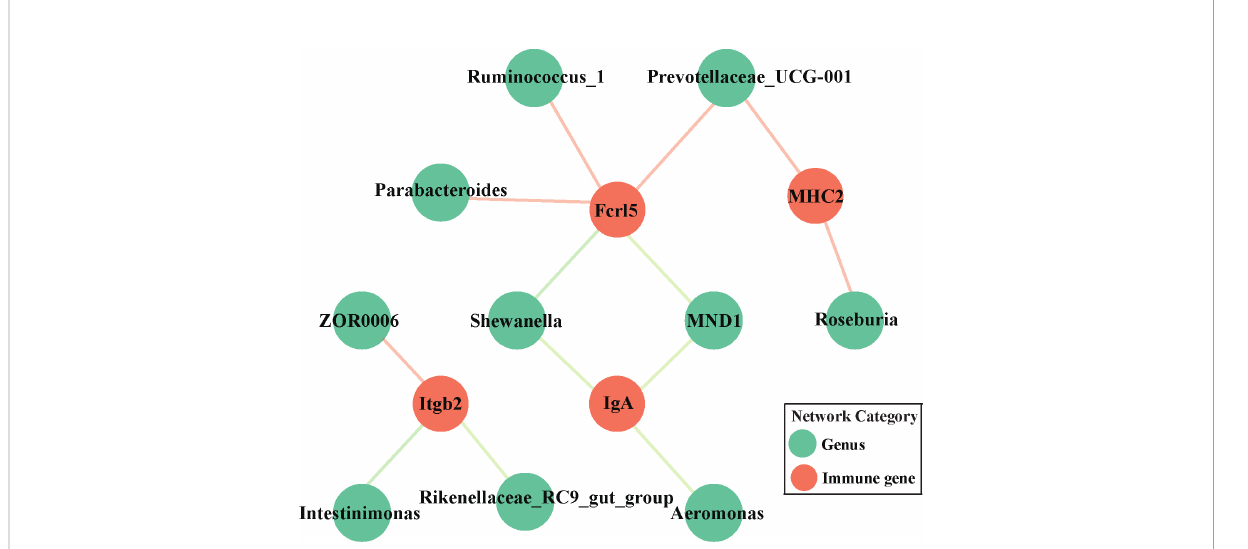
FIGURE 6 Network analysis of the correlation between targeted genera and discriminatory immune-related genes ( IgA , MHC2 , Fcrl5 and Itgb2 ) among all the groups. Orange node is mapped to immune-related genes while green one represents targeted core genera. Pink and light green edges indicate positive and negative correlations,